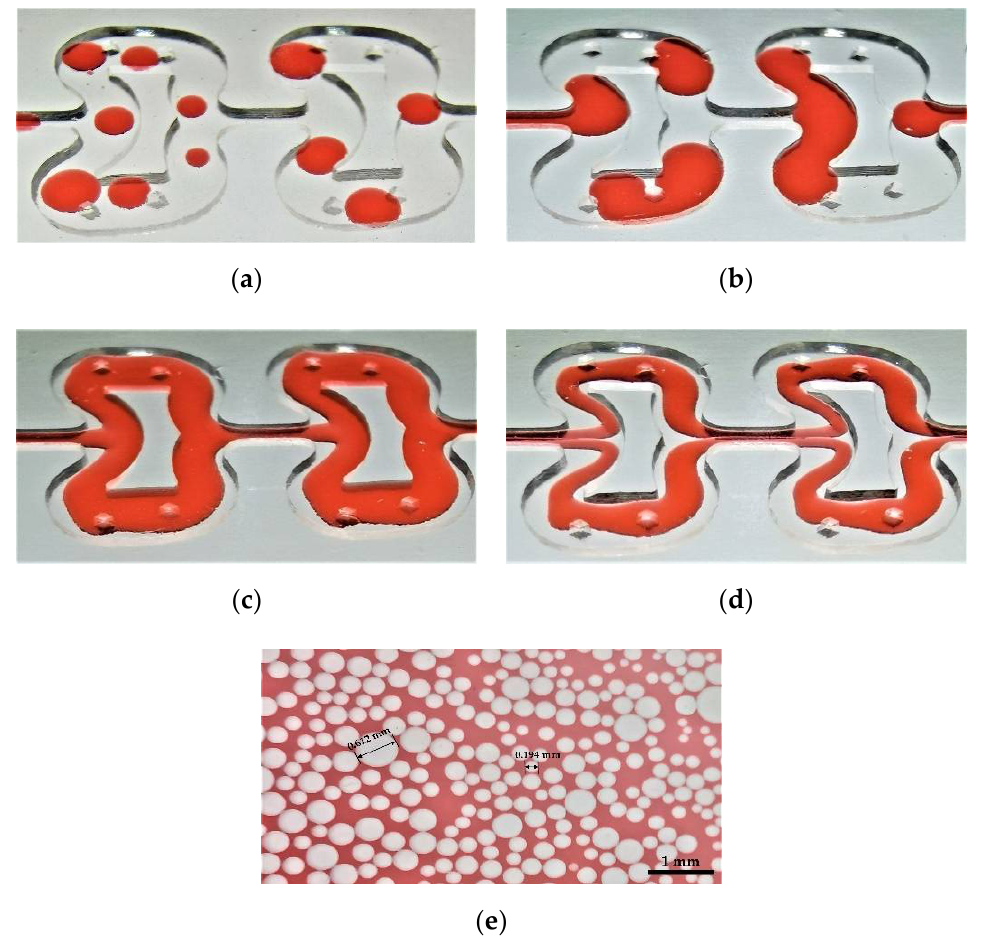
Figure 8. Experimental flow patterns in the microreactor: ( a ) droplet flow; ( b ) Taylor flow; ( c ) stratified flow; ( d ) annular flow; ( e ) dispersed flow.